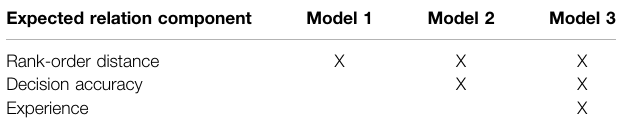
TABLE 1 | Overview of expected relations in each model.